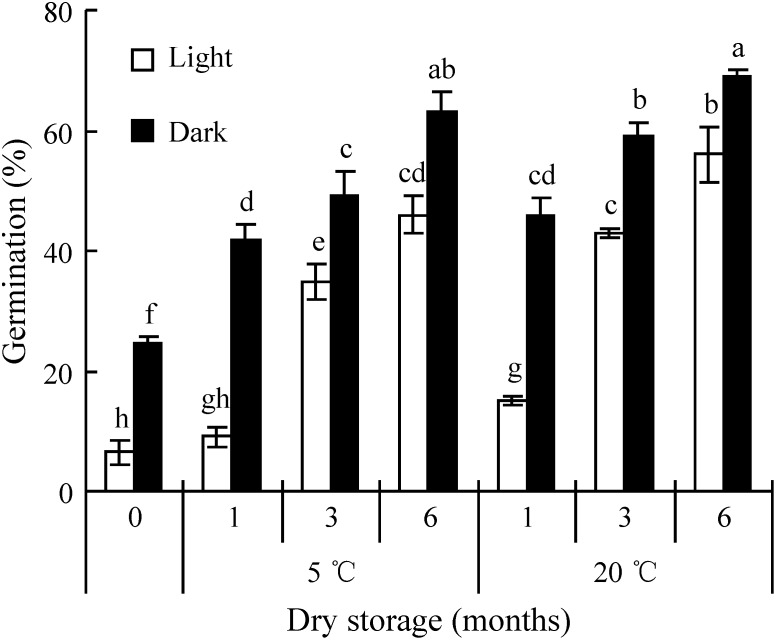
Effect of dry storage (afterripening) on germination of seeds of Stipa bungeana in a 12 h/12 h photoperiod and in dark at 20°C.Different letters indicate significant difference (P<0.05) among all treatments (n = 4).